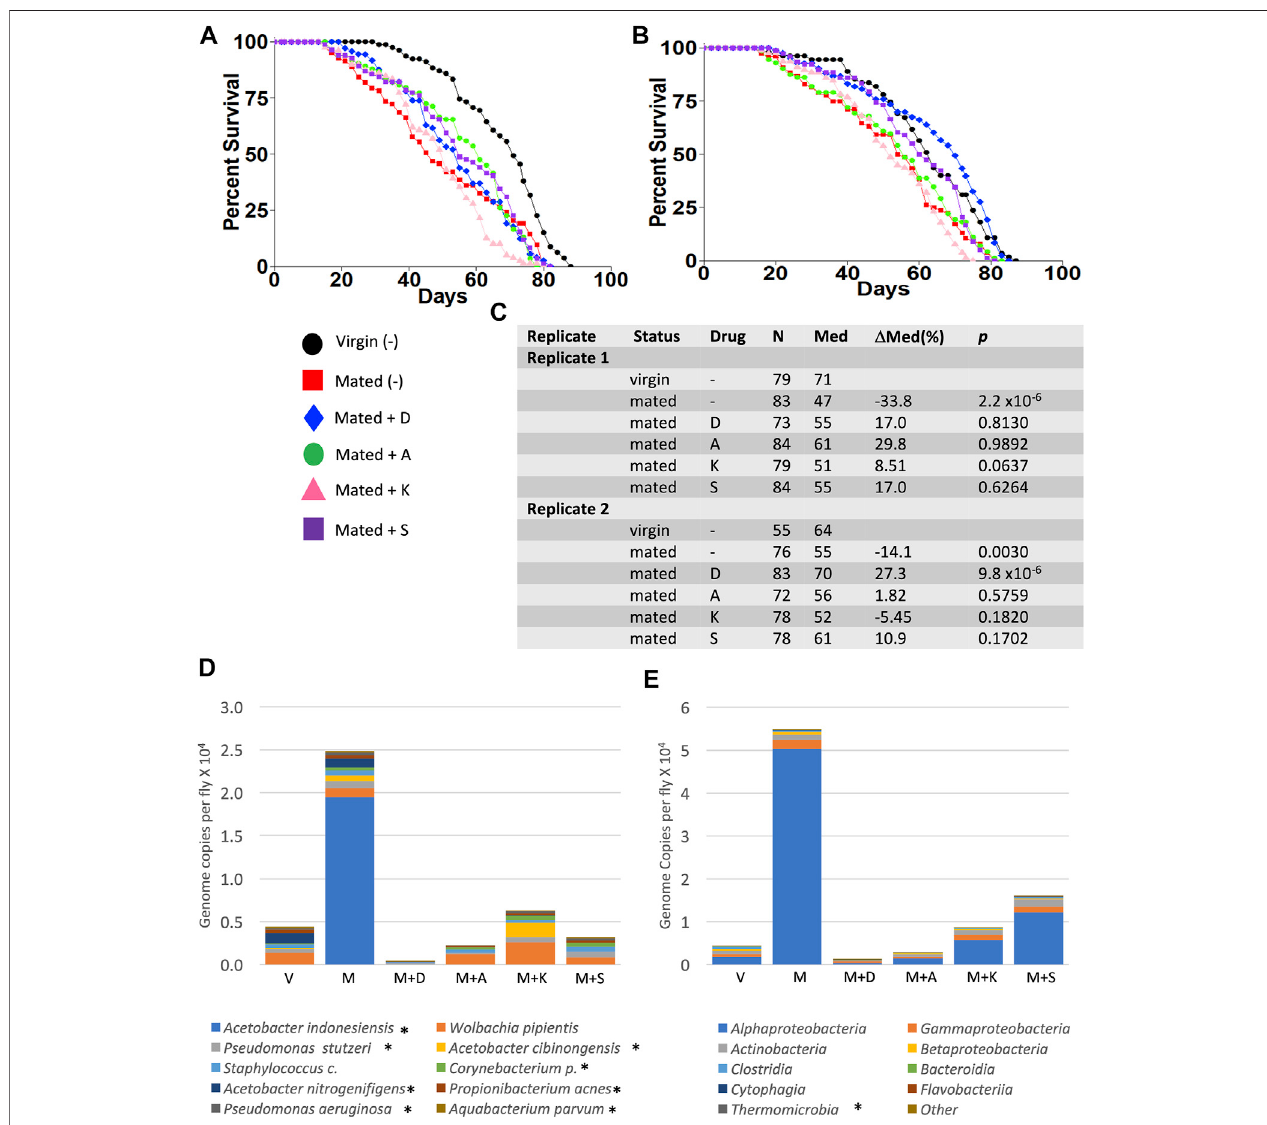
FIGURE6| Effect ofhigh-concentrationantibioticsonmated femalelifespan andmicrobialload.Lifespan wasassayedinreplicate experiments, forvirgin females (V),matedfemales(M),andmatedfemales(M),andmatedfemalestreatedwithdoxycycline(D),ampicillin(A),kanamycin(K),andstreptomycin(S). (A) Experiment 1. (B) Experiment 2. (C) Life span statistical summary. Percent change in median life span was calculated by comparing mated to virgin, and by comparing antibiotic-treated mated to mated. Statistical test: log-rank; p- value for signi fi cance with fi ve comparisons is 0.01. (D) Average bacterial species (excluding outliers). (E) Average bacterial classes (excluding outliers). Species and classes reported to be aero-tolerant are indicated with asterisk.